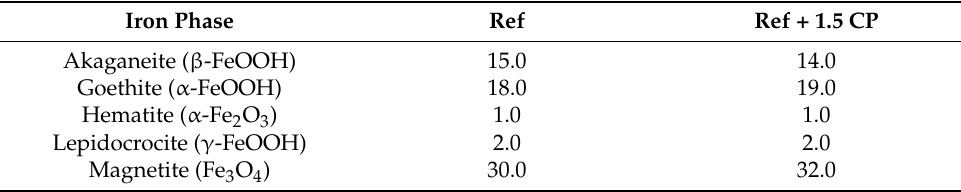
Figure 7. XRD diffractogram of corrosion byproduct showing: magnetite (1); goethite (2); quartz (3); lepidocrocite (4); hematite (5); akaganeite (6); α-Fe (7); albite low (8); calcite (9); and clinochlore (10). Table 4. Composition of expansive iron phases in corrosion residue (wt %).